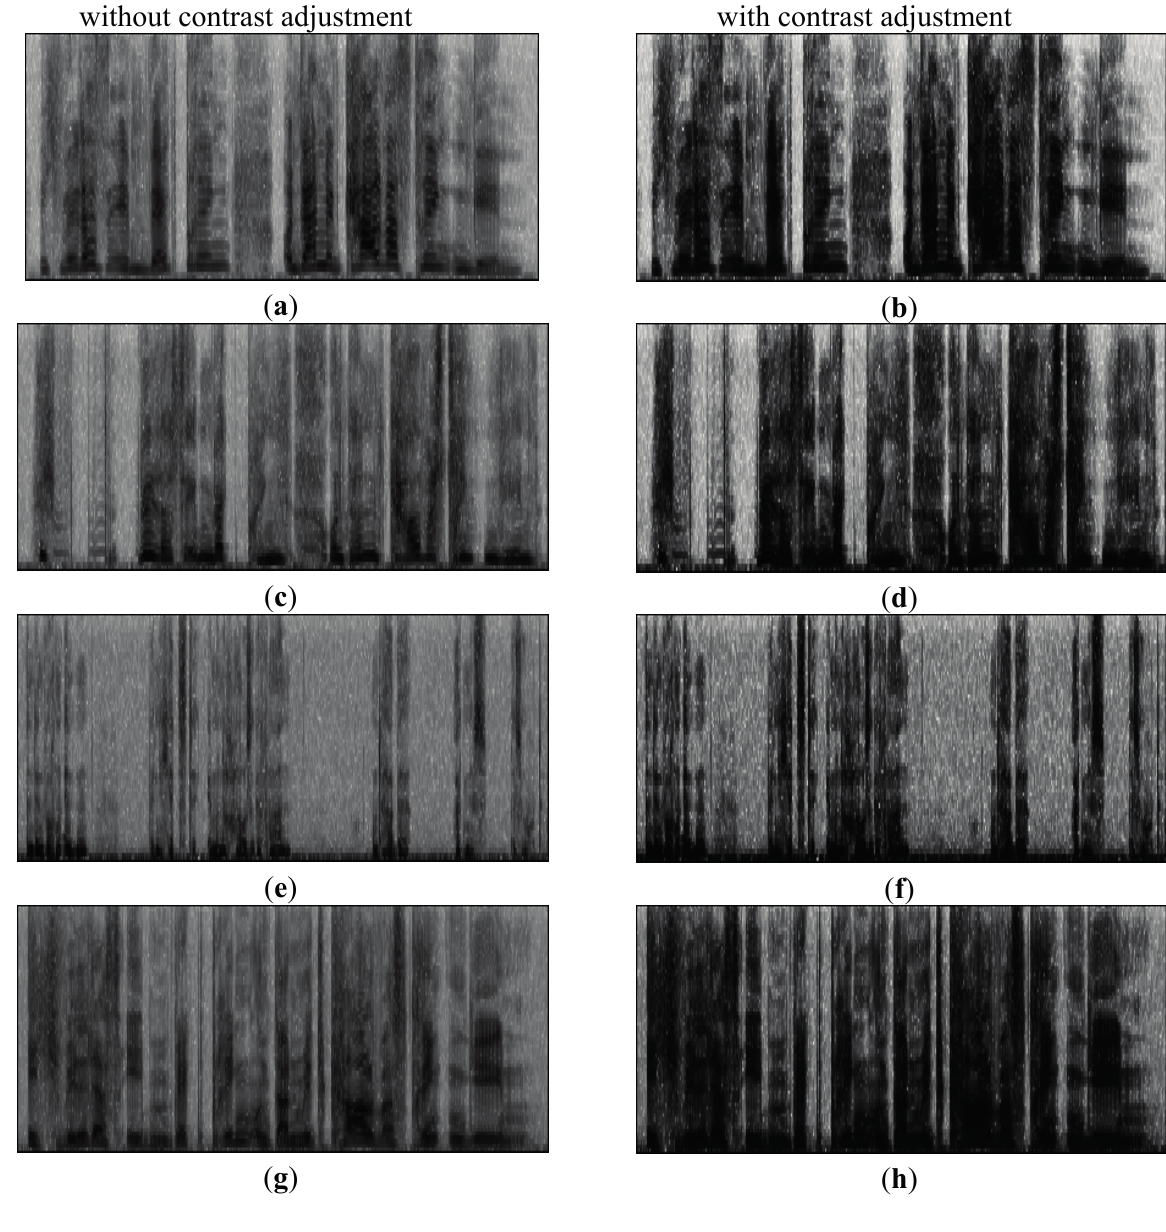
Figure 5. Spectrogram without/with contrast adjustment after the original image: ( a ) and ( b ) represent “Happiness”, ( c ) and ( d ) denote “Fear”, ( e ) and ( f ) are “Sadness”, ( g ) and ( h ) are